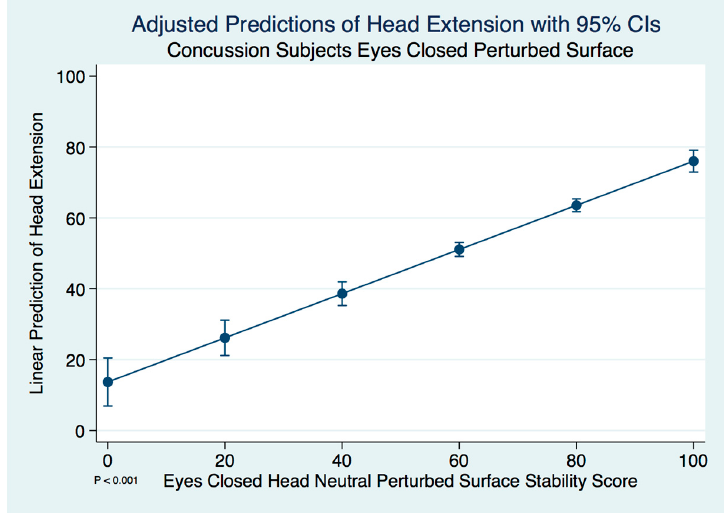
Figure 7. Adjusted predictions of head flexion stability scores in concussion subjects. Figure 7. Adjusted predictions of head extension stability scores in concussion subjects.